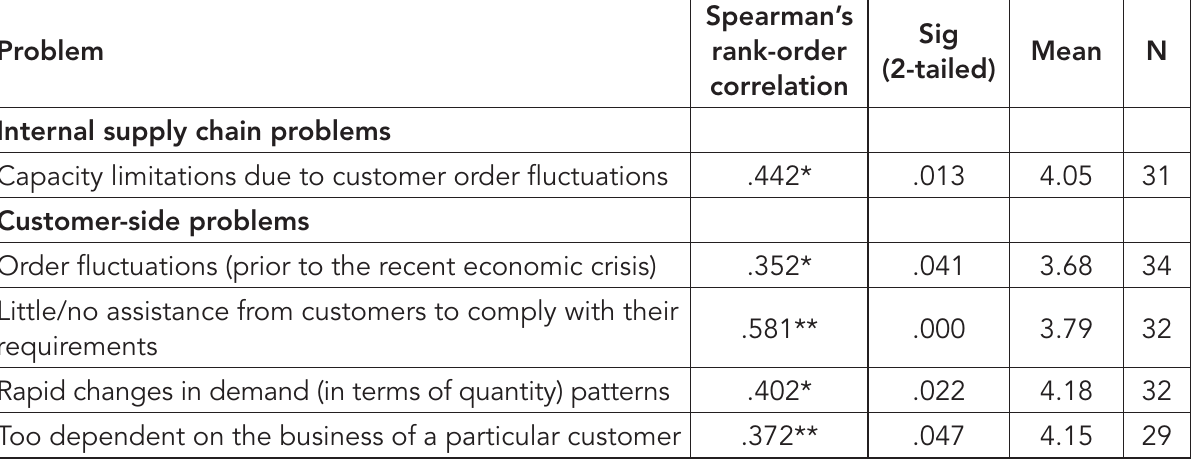
Table 3: Significant correlation between financial stability of